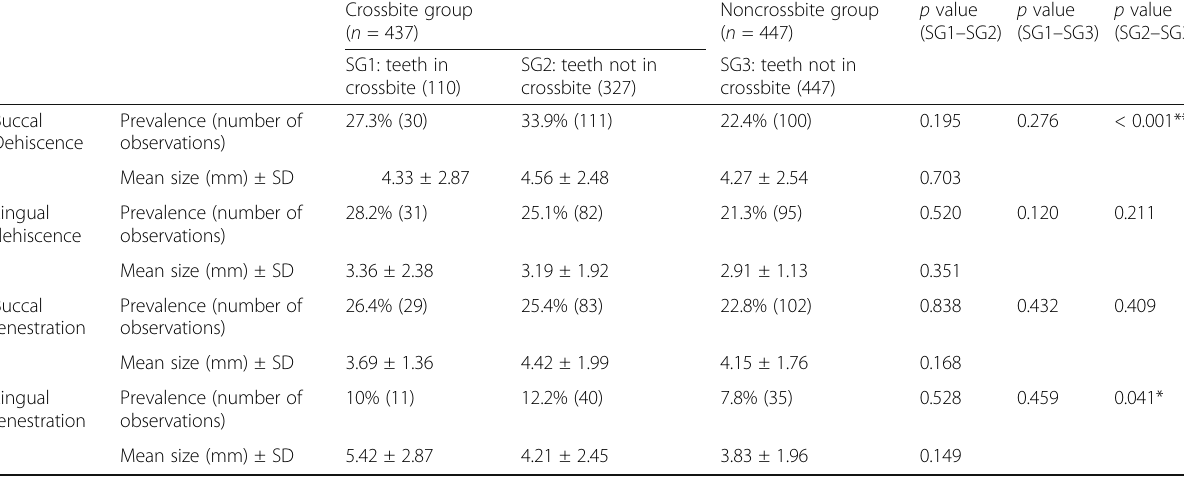
Table 7 Dehiscence and fenestration prevalence and mean size by buccal and lingual surfaces by subgroup